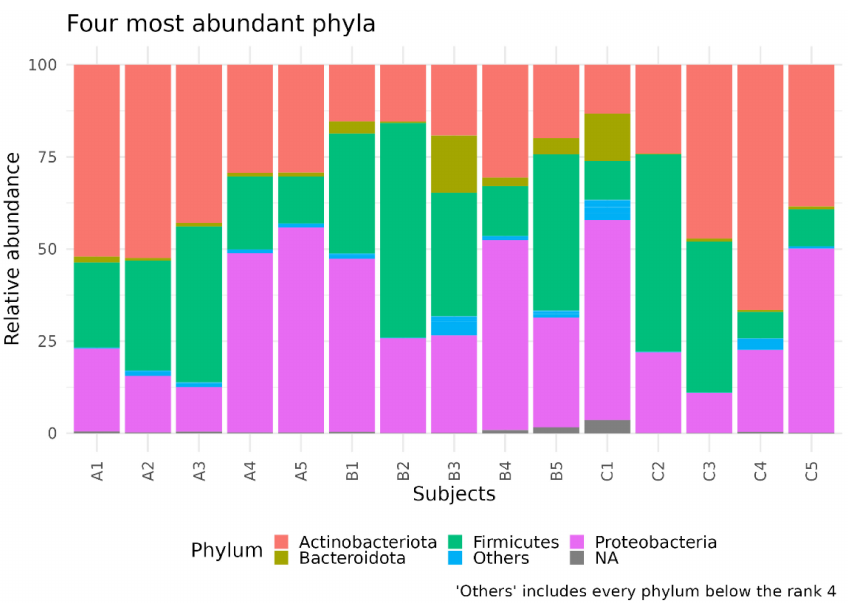
Figure 1. Taxonomic composition of facial skin samples. The stacked bar plot shows the relative abundance of the four more abundant bacterial phyla in each sample. The “Others” group contains phyla with ranks below five.